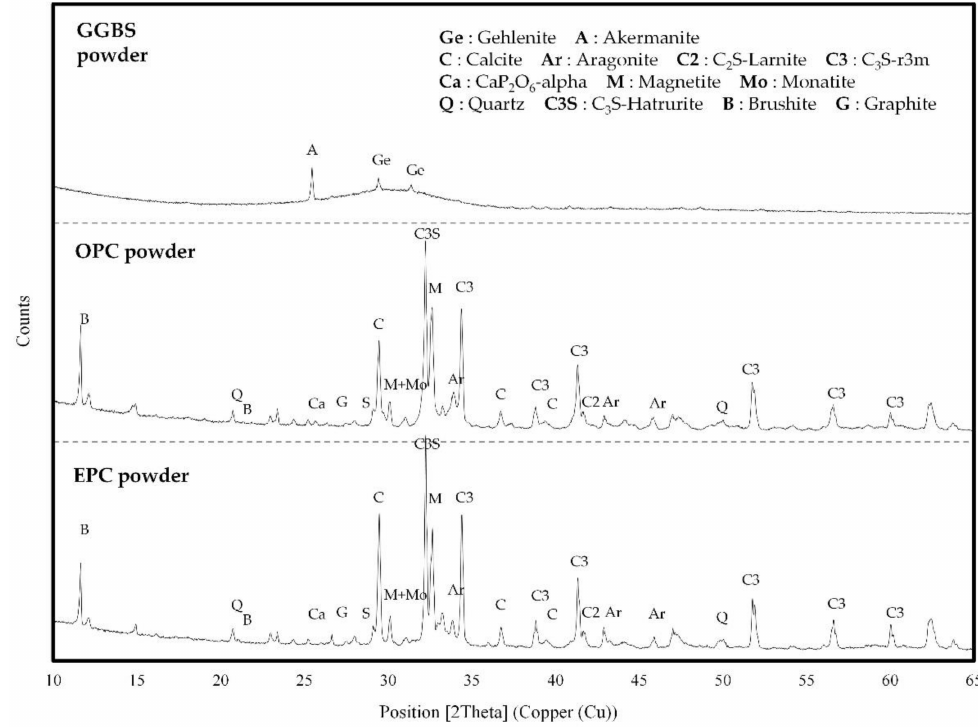
Figure 5. X-ray diffraction patterns of GGBS, OPC, and